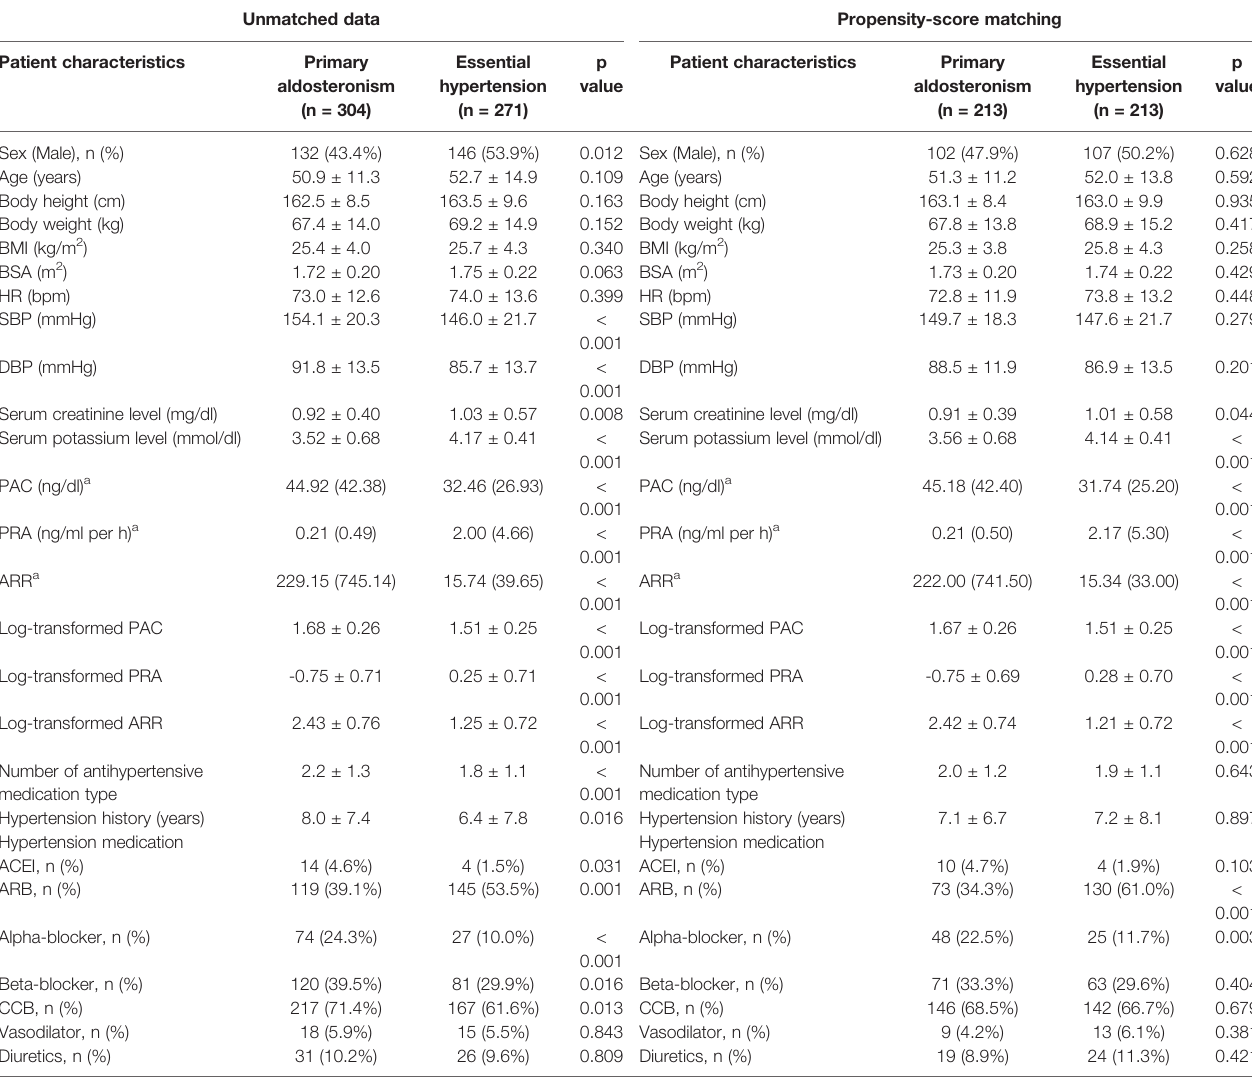
TABLE 1 | Clinical characteristics of patients with primary aldosteronism and essential